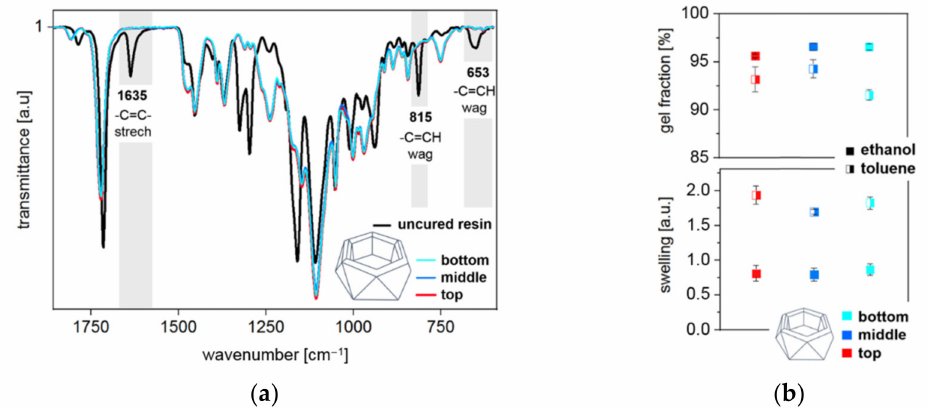
Figure 6. ( a ) Superimposed FT-IR spectra of the top (1–13 mm), middle (14–27 mm), and bottom (28–40 mm) regions are in exact congruence. Comparison with the uncured resin underlines high double bond conversion. ( b ) Swelling experiments were performed in toluene and ethanol. A slightly reduced gel-content is observed with toluene in the bottom region. Nevertheless, swelling, as well as gel-content, demonstrate uniformity over the sample depth.